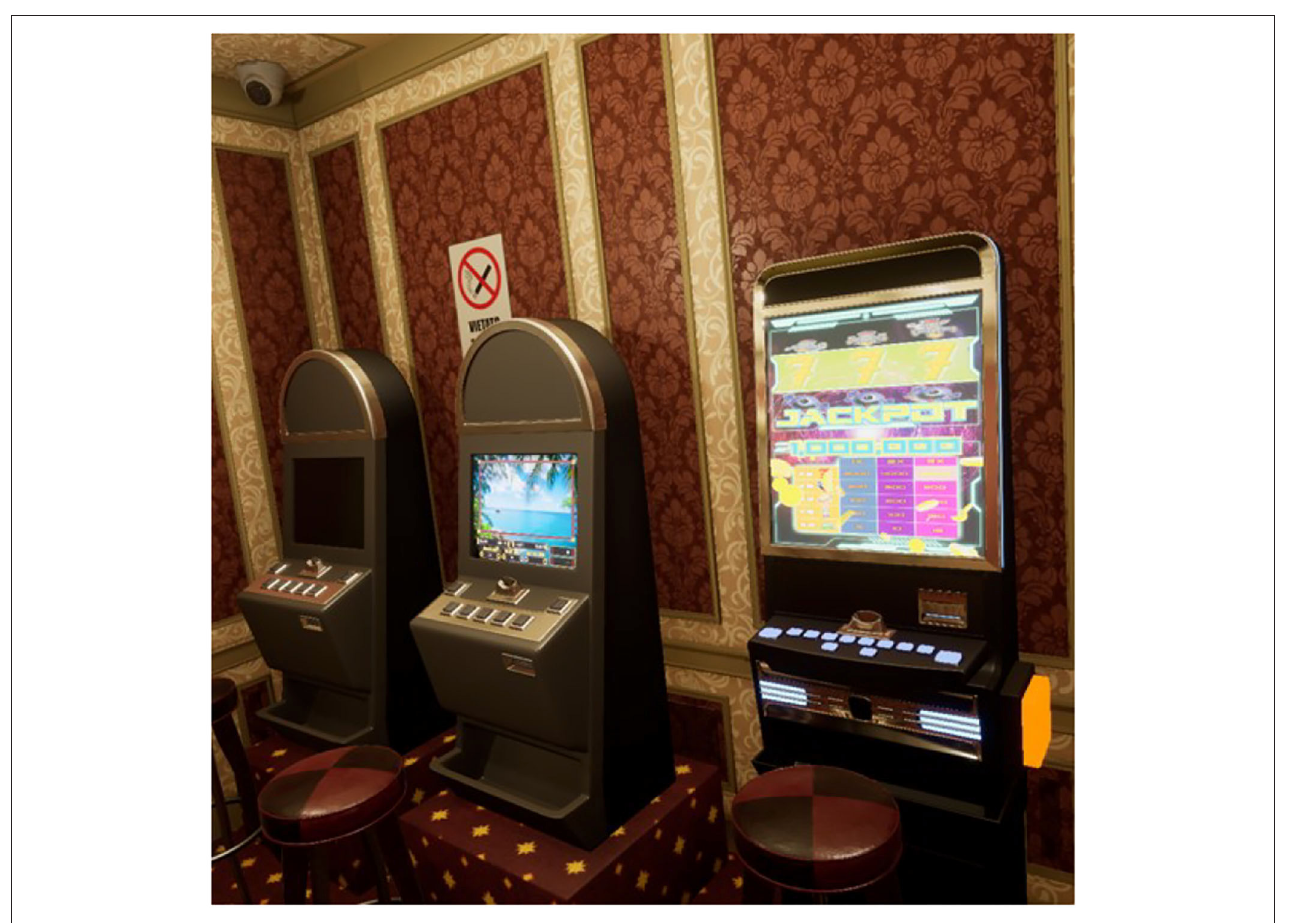
FIGURE 7 | The non-smoking slot room with some slots turned off and